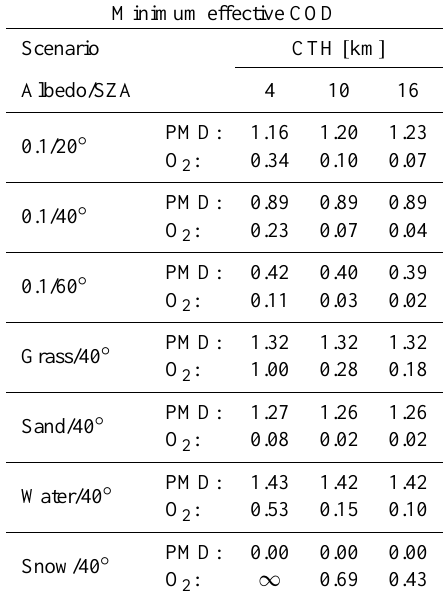
Table 1. Minimum detectable effective cloud optical depth (eCOD) for the PMD and O 2 based WFM-DOAS cloud detection algo- rithms for various scenarios as defined by surface albedo and solar zenith angle (SZA). The following settings have been used for all scenarios: aerosols: default scenario (see main text); clouds: cloud geometrical thickness CGT=0.5km and cloud fractional coverage CFC=1.0. “ ∞ ” means that even clouds with large eCOD are not detected. “0.00” means that clouds are “detected” even if the scene is cloud